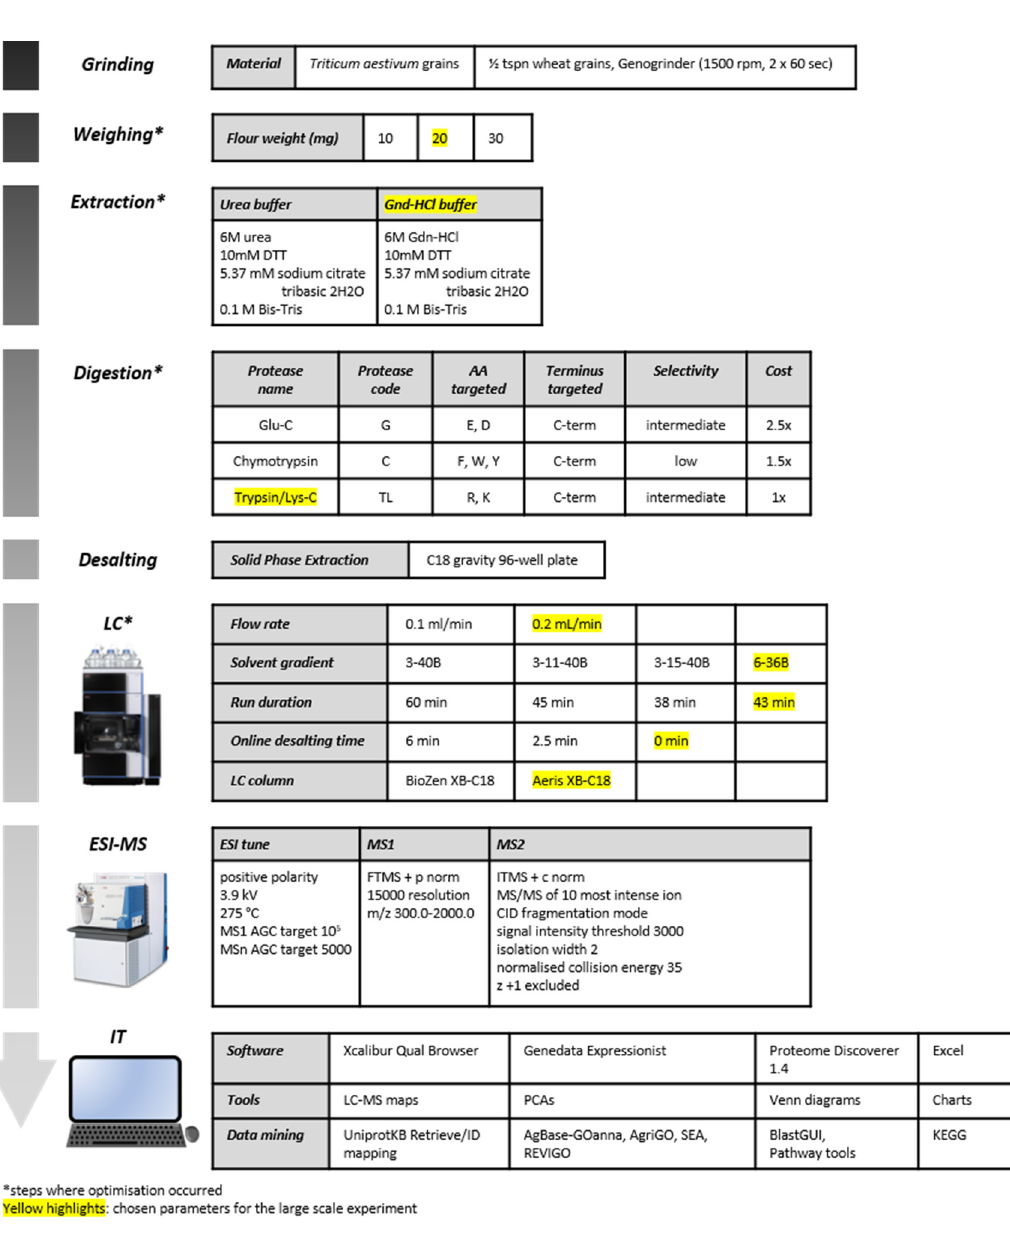
Figure 1. Experimental design. The asterisk denotes where technical optimisation occurred, and the yellow highlights indicate which parameters were selected for the large-scale experiment.